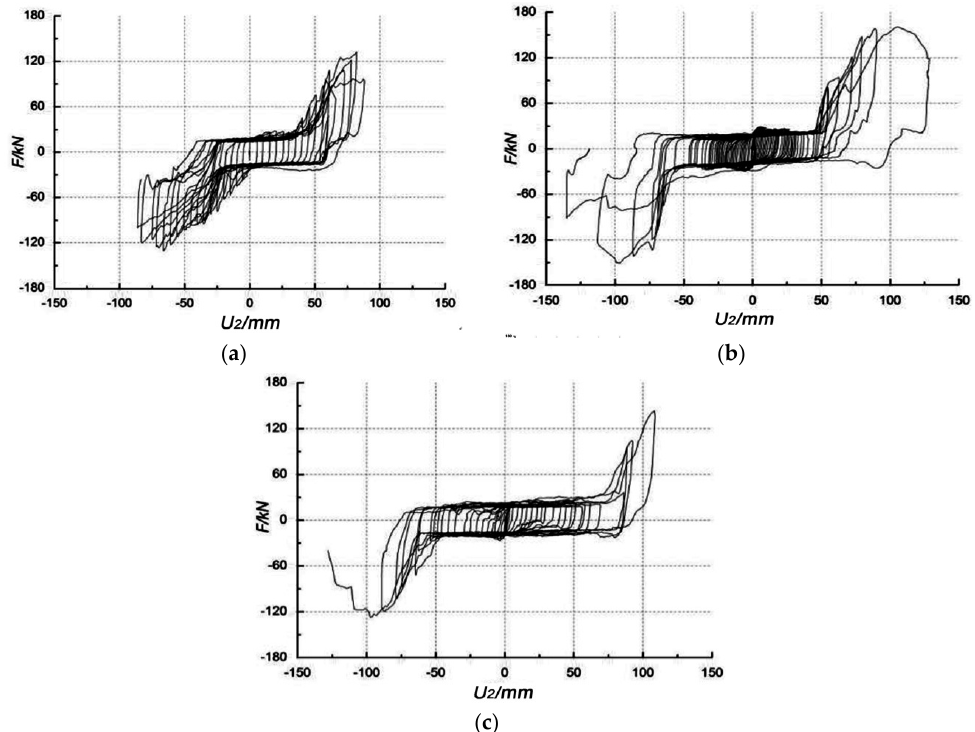
Figure 16. F ‐ U 2 hysteretic Curves: ( a ) GGBW ‐ 1; ( b ) GGBW ‐ 3; ( c ) GGBW ‐ 4. Figure 16. F-U 2 hysteretic Curves: ( a ) GGBW-1; ( b ) GGBW-3; ( c )